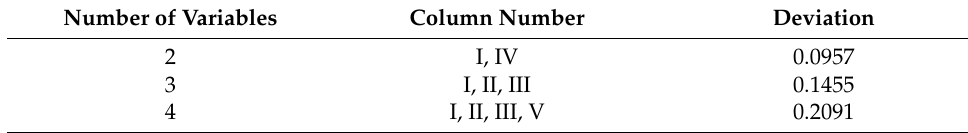
Table 2. Guidelines for selecting columns of generating vectors in U 14 *(14 5 ).